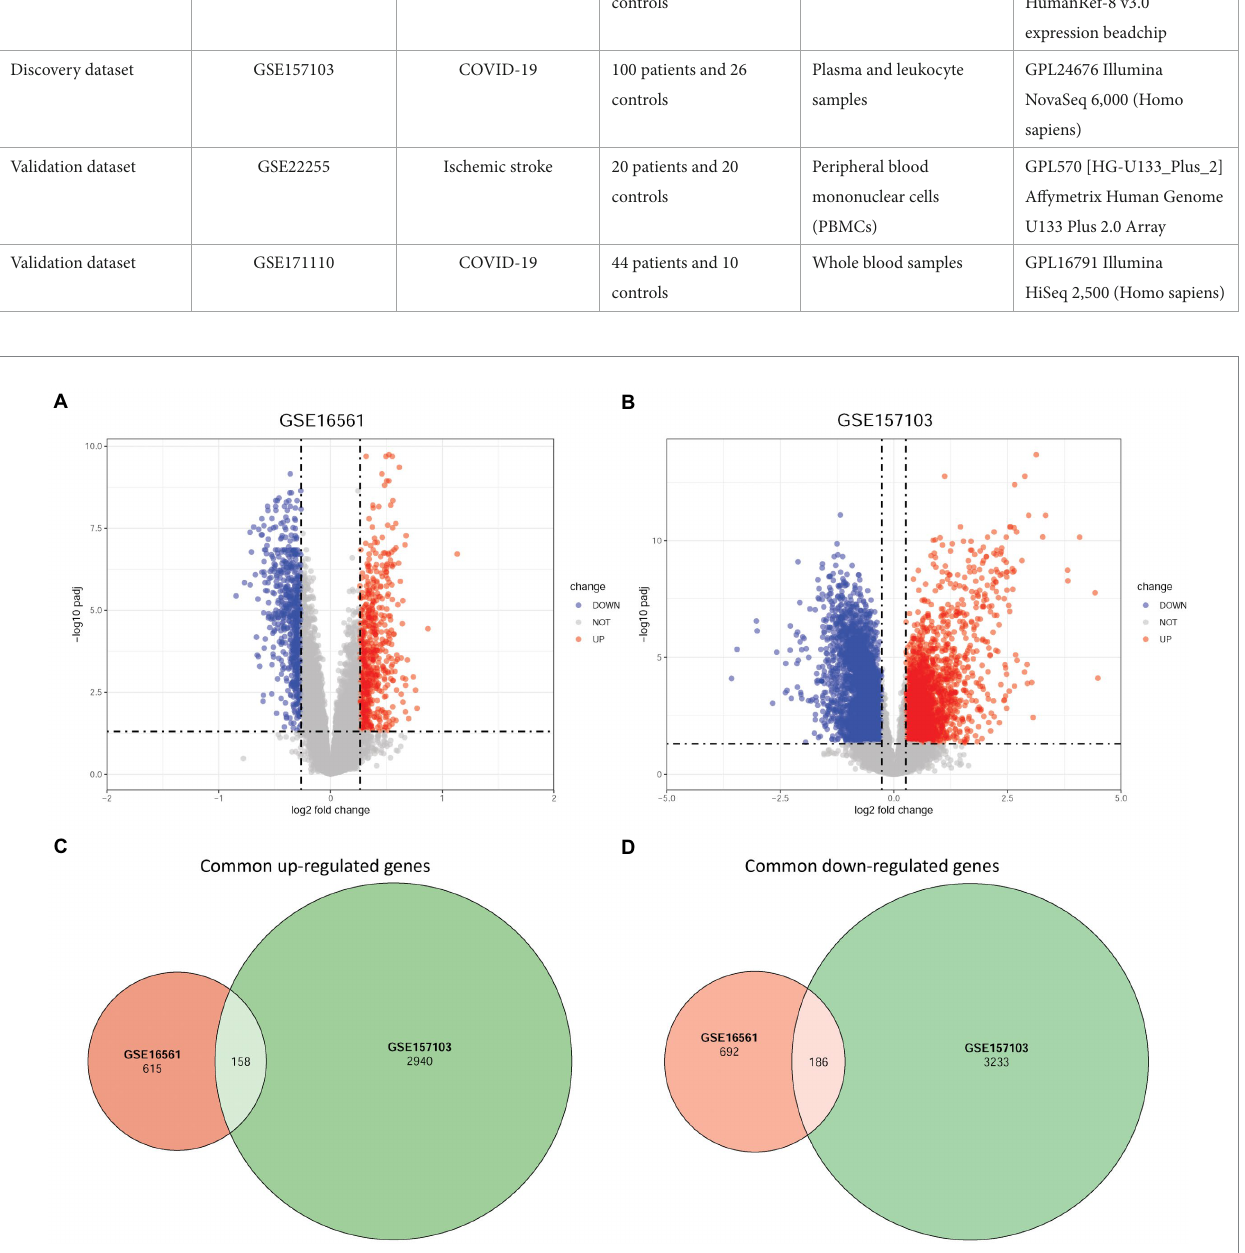
FIGURE 1 Identification of DEGs based on GSE16561 and GSE157103 datasets. (A) Volcano plot of DEGs between IS and normal samples based on the GSE16561 dataset. (B) Volcano plot of DEGs between COVID-19 and normal samples based on the GSE157103 dataset. (C) Venn diagram of up-regulated DEGs identified based on the two datasets. (D) Venn diagram of down-regulated DEGs identified based on the two datasets. DEGs, differentially expressed genes; IS, ischemic stroke; COVID-19, coronavirus disease